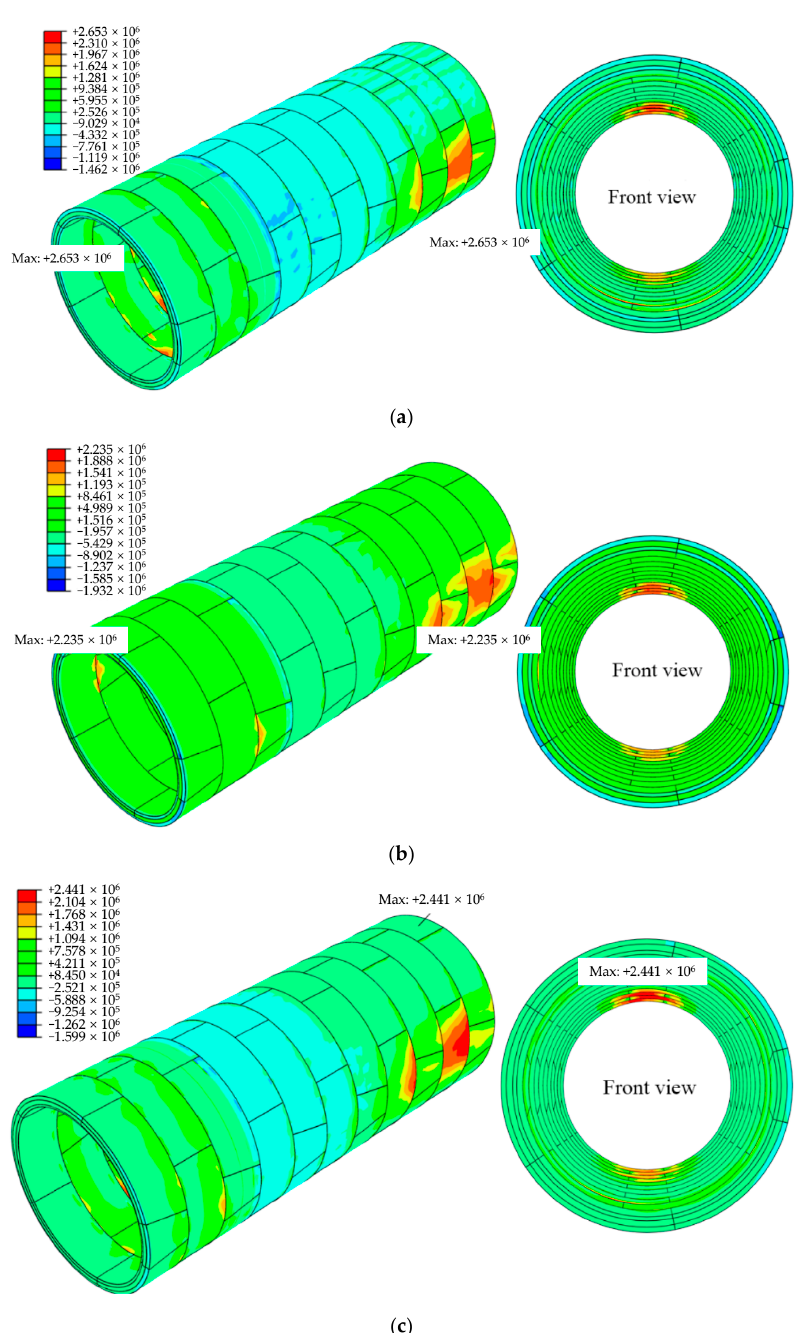
Figure 16. Maximum stress of segmental lining structures. ( a ) Upward direction of shield machine. ( b ) Downward direction of shield machine. ( c ) Left direction of shield machine.